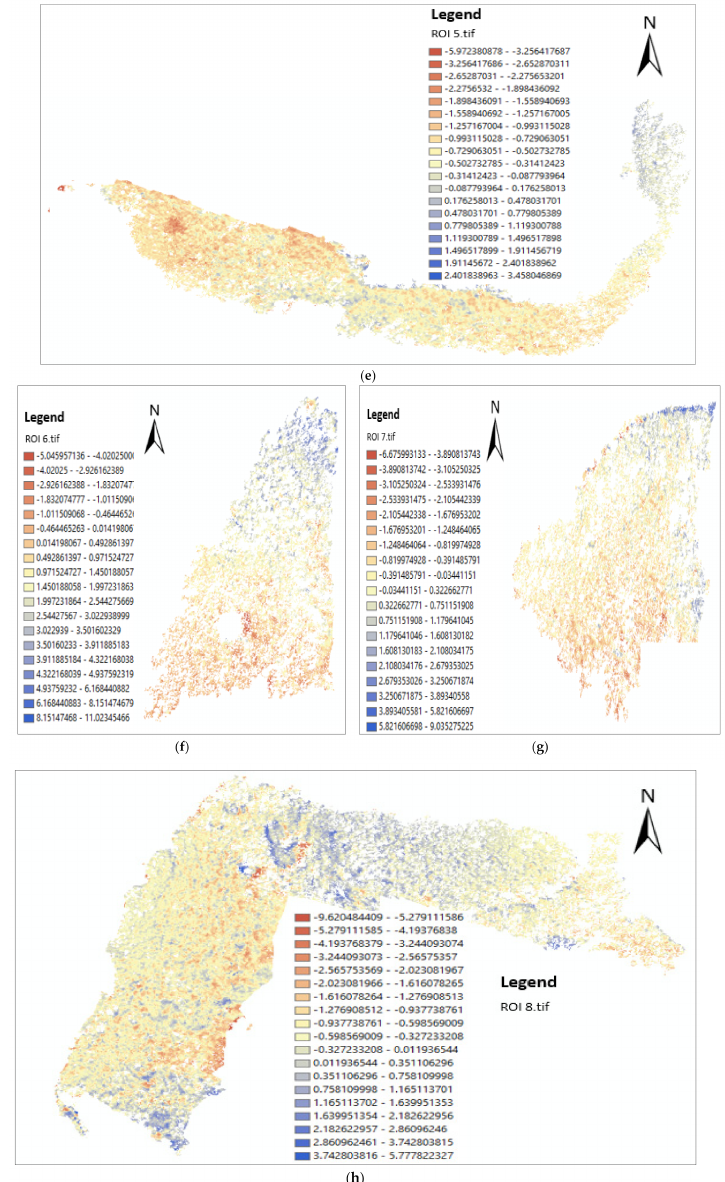
Figure 8. The result of change detection at different ROIs at Kilim River using GCD software: ( a ) ROI 1; ( b ) ROI 2; ( c ) ROI 3; ( d ) ROI 4; ( e ) ROI 5; ( f ) ROI 6; ( g ) ROI 7; ( h ) ROI